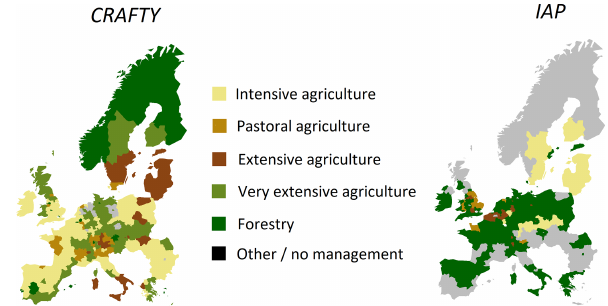
Figure 4. Territorial differences between the models’ results across all scenarios at NUTS2 level. Colours identify the most over- represented land use type in each region in the CRAFTY and IAP results relative to the result of the other model (i.e. the land use with the biggest difference in occurrence in that region). Grey is shown where no land use type has an over-representation of more than 5% of the region’s cells. Scenario-specific results are shown in Fig.